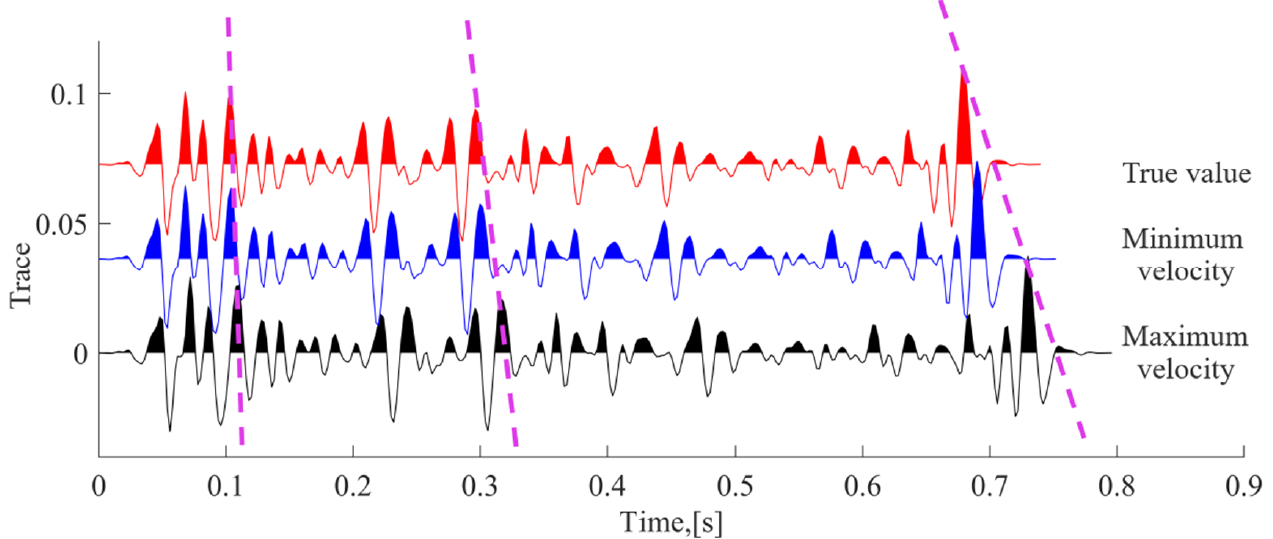
Figure 8. Comparison of synthetic seismic data by using upscaled velocity from the maximum and minimum velocity of constant Q model in Figure 6a.